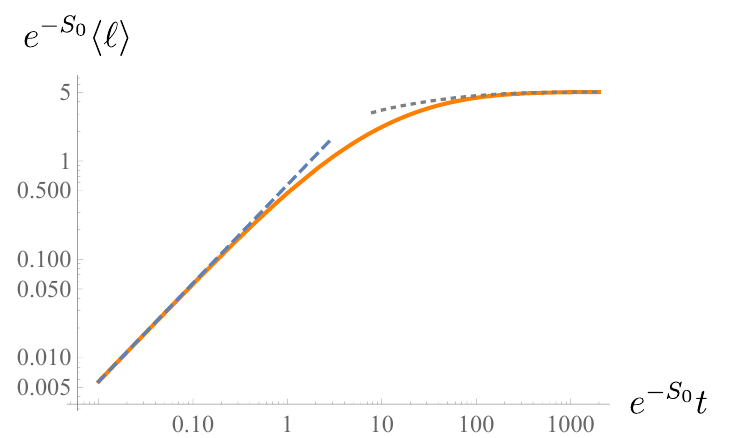
Figure 1 . We show the numerical evaluation of the Einstein-Rosen bridge length (see (4.6)) in JT gravity for β = 15 in orange, while the early and late time asymptotics (4.9) are shown by the blue dashed and gray dotted curves,